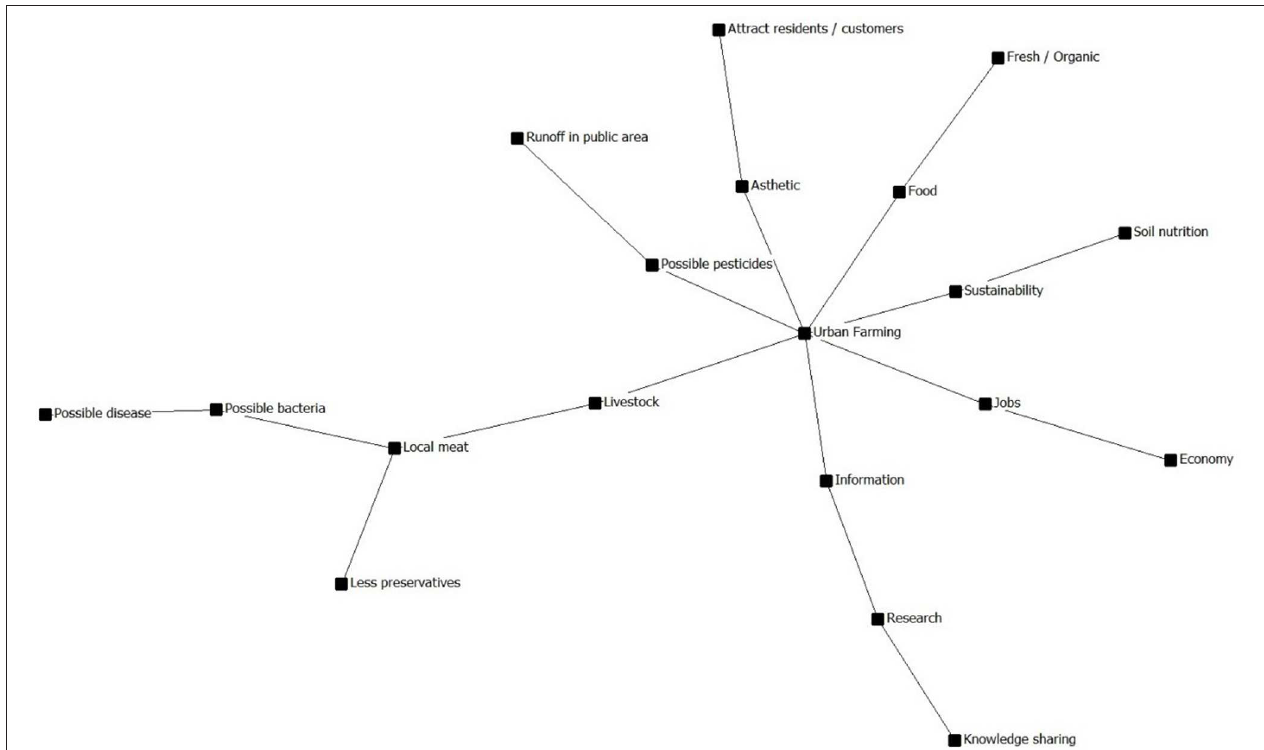
FIGURE 3 | Example of an individual network 1 (location 1, ID